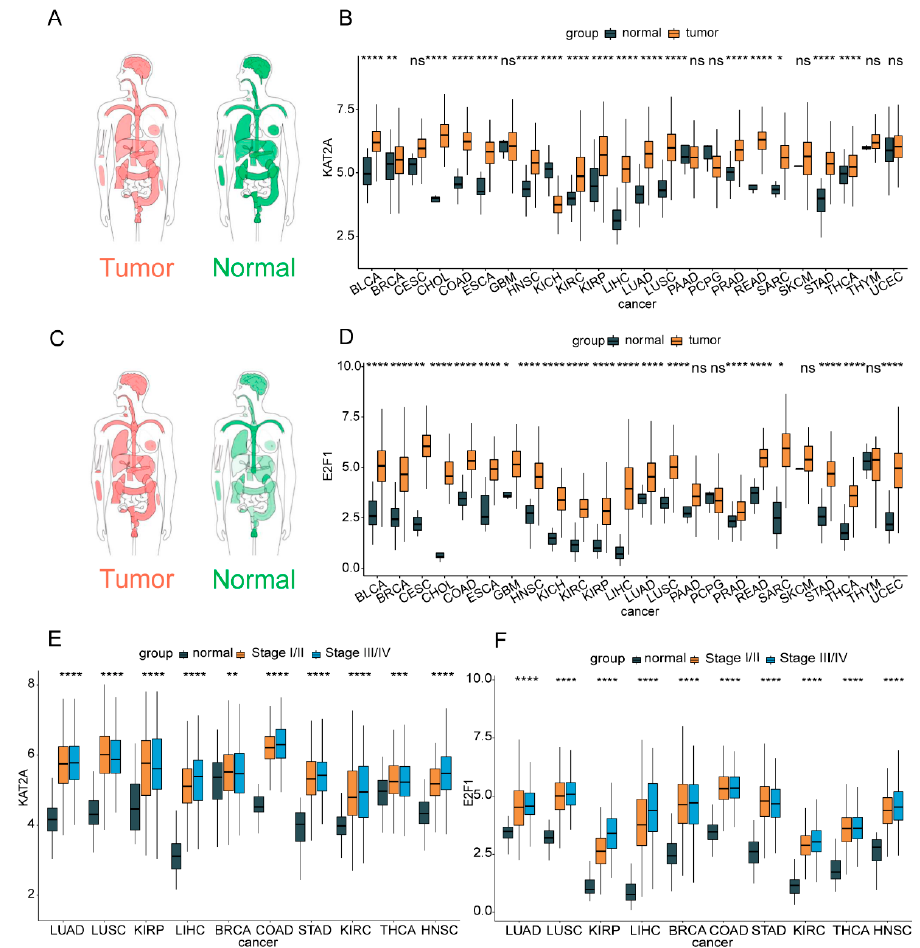
Figure 1. The expression levels of KAT2A and E2F1 in pan-cancer tissues and cells. The expression profiles of KAT2A ( A , C ), E2F1 in a normal person and patients. The darker the color, the higher the gene expression. The expression levels of KAT2A ( B ) and E2F1 ( D ) in TCGA pan-cancer tissue and normal tissue samples. The expression levels of KAT2A ( E ) and E2F1 ( F ) in pathological stages. The statistical significance was analyzed by Student’s t -test (two-tailed) analysis. ACC, adrenocortical carcinoma; BLCA, bladder urothelial carcinoma; BRCA, breast invasive carcinoma; CESC, cervical squamous cell carcinoma and endocervical adenocarcinoma; CHOL, cholangiocarcinoma; COAD, colon adenocarcinoma; DLBC, lymphoid neoplasm diffuse large B-cell lymphoma; ESCA, esophageal carcinoma; GBM, glioblastoma multiforme; HNSC, head and neck squamous cell carcinoma; KICH, kidney chromophobe; KIRC, kidney renal clear cell carcinoma; KIRP, kidney renal papillary cell carcinoma; LAML, acute myeloid leukemia; LGG, brain lower grade glioma; LIHC, liver hepato- cellular carcinoma; LUAD, lung adenocarcinoma; LUSC, lung squamous cell carcinoma; MESO, mesothelioma; OV, ovarian serous cystadenocarcinoma; PAAD, pancreatic adenocarcinoma; PCPG, pheochromocytoma and paraganglioma; PRAD, prostate adenocarcinoma; READ, rectum adenocar- cinoma; SARC, sarcoma; SKCM, skin cutaneous melanoma; STAD, stomach adenocarcinoma; TGCT, testicular germ cell cancers; THCA, thyroid carcinoma; THYM, thymoma; UCEC, uterine corpus endometrial carcinoma; UCS, uterine carcinosarcoma; UVM, uveal melanoma. *: p < 0.05; **: p < 0.01; ***: p < 0.001; ****: p < 0.0001; ns: no